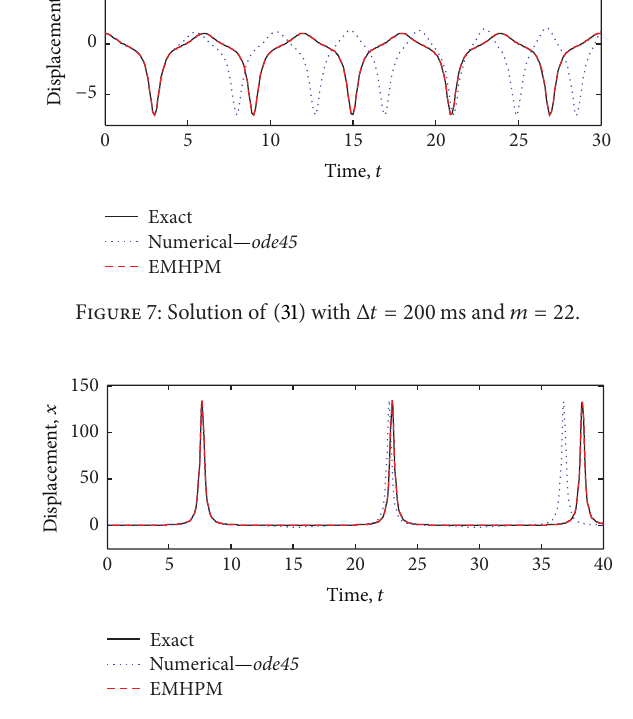
Figure 8: Solution of (31) with Δ𝑡 = 60 ms and 𝑚 = 27